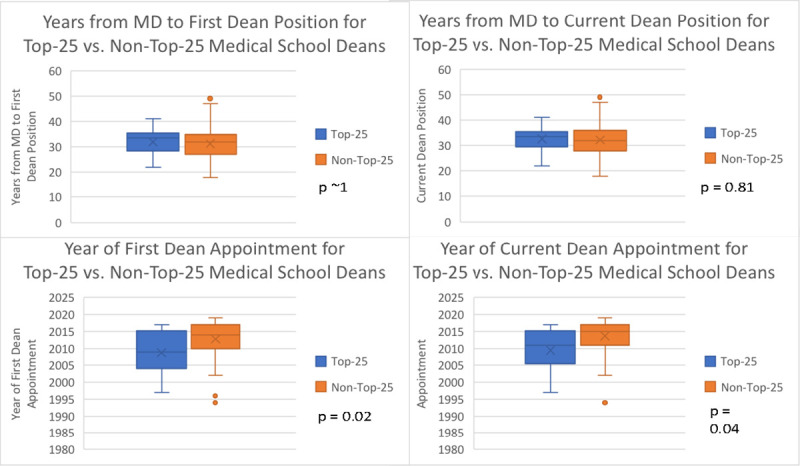
Progression through the pipeline according to medical school rank.This figure depicts data from a study of Deans of U.S. Schools of Medicine (95 of 153 total whose CVs were available for review). When comparing Deans at Top-25 Medical Schools based on U.S. News & World Report’s 2019 research school ranking (top row), there were no significant differences in the number of years between achieving their MD degree to promotion to either the first or current Dean of Medicine position. There were differences in the era of DOM appointments, however, with Top-25 Deans being more likely to have been appointed to both their first and current DOM positions at early timepoints than non-Top-25 Deans (bottom row, p = 0.02 and 0.04, respectively).